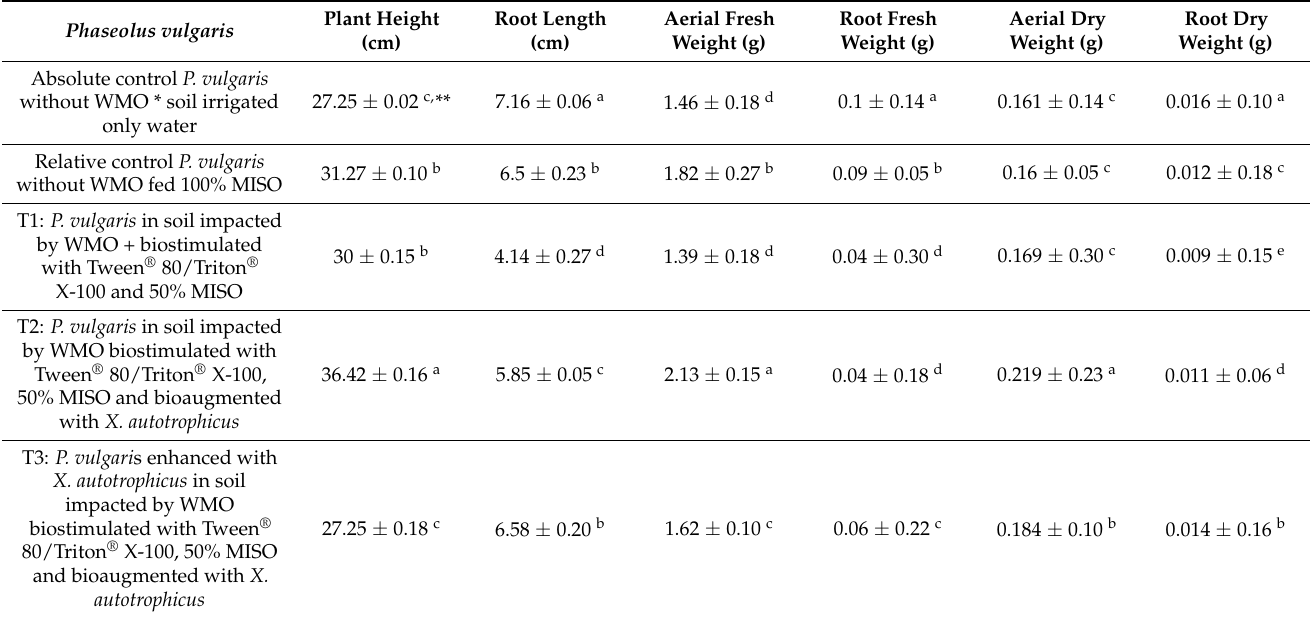
Table 4. Phenology and biomass of Phaseolus vulgaris enhanced with Xanthobacter autotrophicus at seedling level during phytoremediation of soil impacted by remainder waste motor oil.